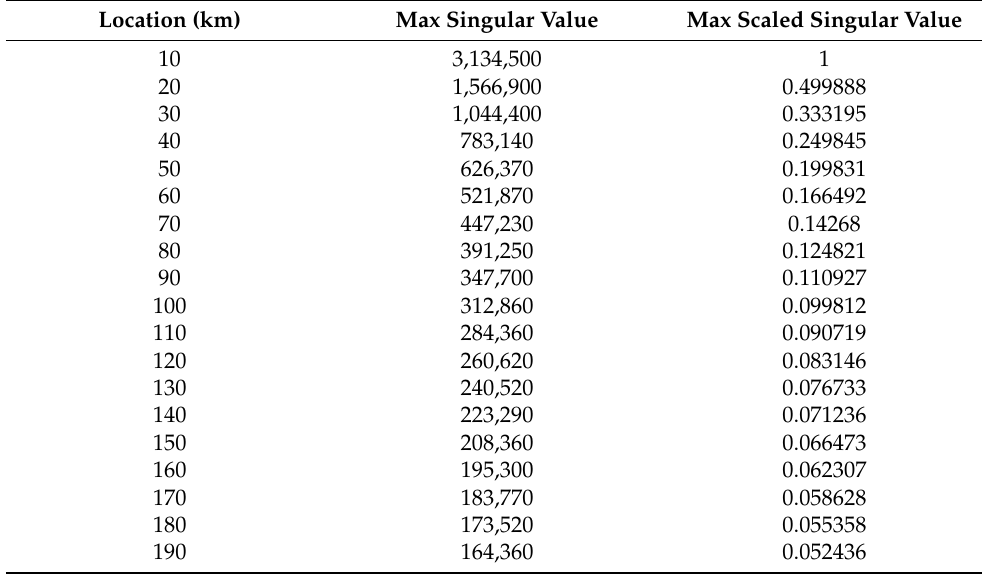
Table A12. The maximum singular and its scaled values for LLL-G fault at 19